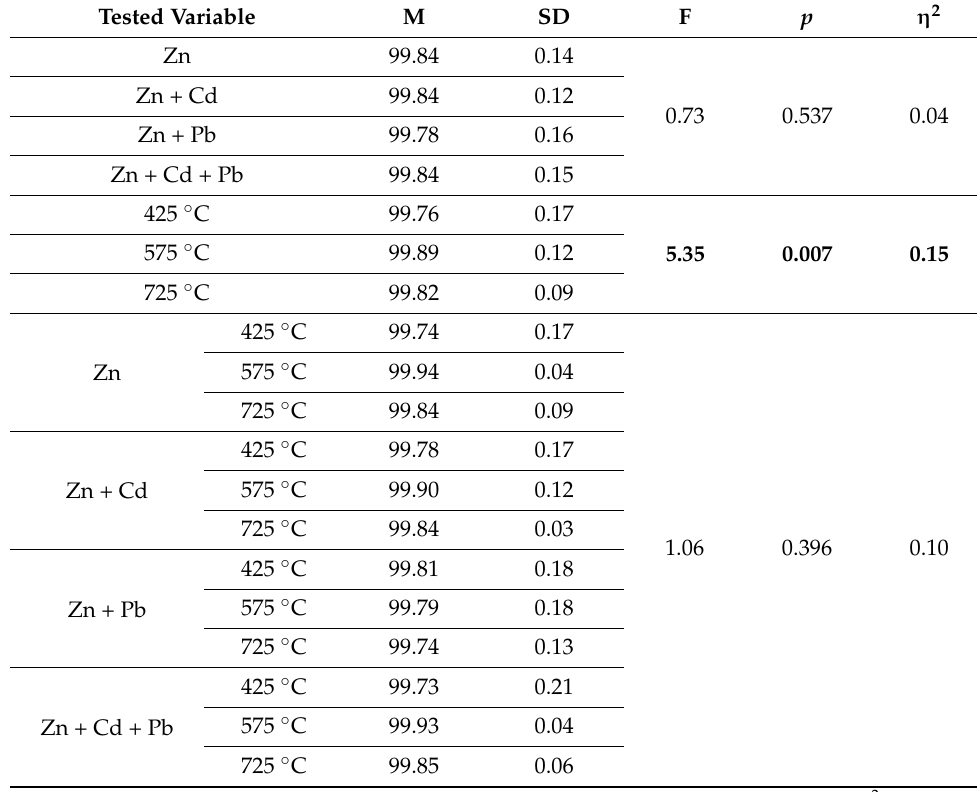
Table 11. Statistical analysis for sorption of Zn (% of removal) in regard to metal combination in the solution and the pyrolysis temperature. Tested